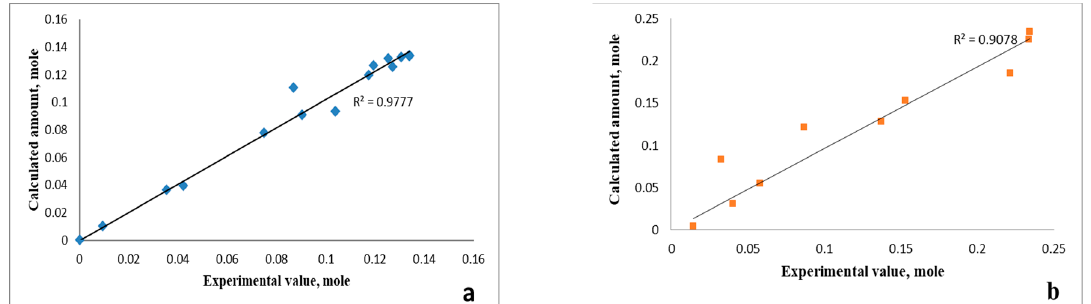
Figure 12. Correlation between calculated and experimental amounts of PET and total potassium ions at PET/KSt = 1.5 molar ratio and different reaction conditions: ( a ) in different polyols at 170 °C; ( b ) in crude glycerol at 190 °C.